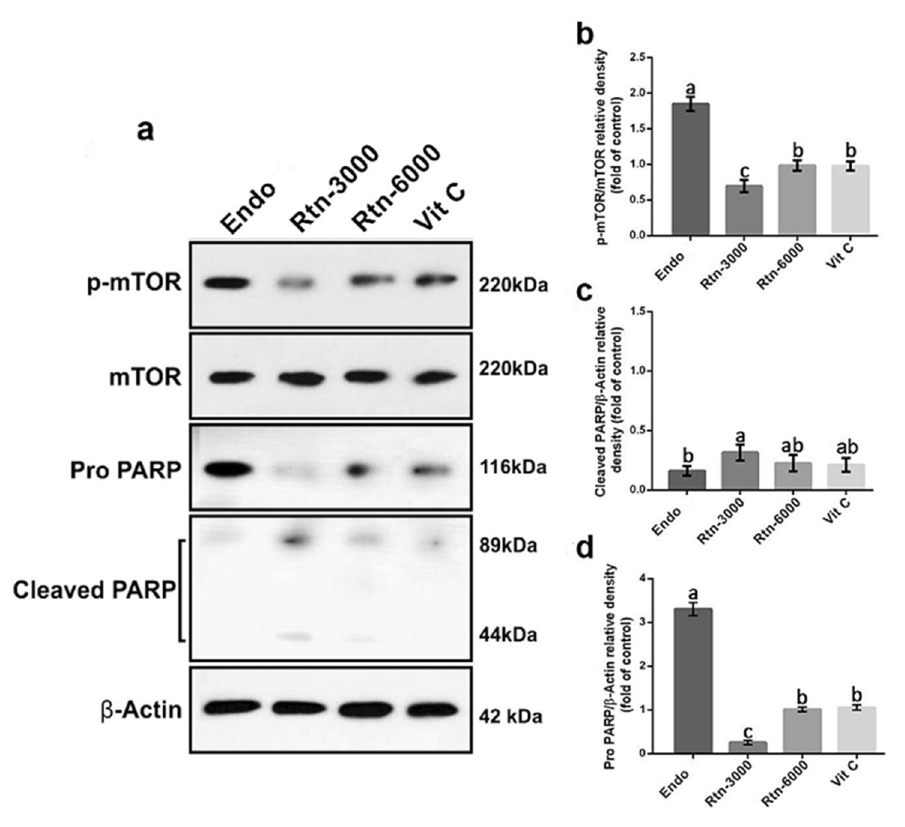
Figure 2. ( a ) Determination of p-mTor, mTOR, Pro PARP, Cleaved PARP and β-actin by Western blot in cell lysates. Western blotting of p-mTOR, mTOR, Pro PARP and Cleaved PARP were performed on lysates of the various cell lines by specific antibodies. β actin was used as an internal control. ( b ), ( c ) and ( d ), Quantitative analyses of p-mTOR, mTOR, Pro PARP and Cleaved PARP were performed in the various cell lines by Western blot analysis. The mean optical density ratio for p-mTor, mTOR, Pro PARP and Cleaved PARP was calculated in per endometriotic cell type and compared to control endometrial cells. Superscripts (a, b, c) show significant differences between groups at P <